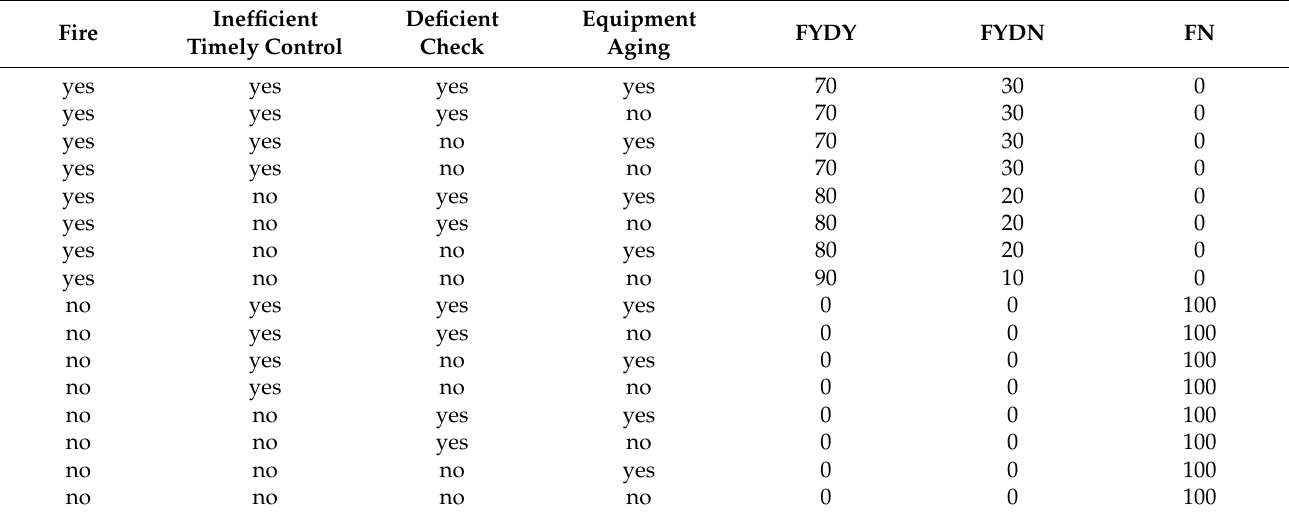
Table A3. CPT for the four parent nodes, i.e., fire, inefficient timely control, deficient check, and equipment aging. Inefficient Fire Timely Control